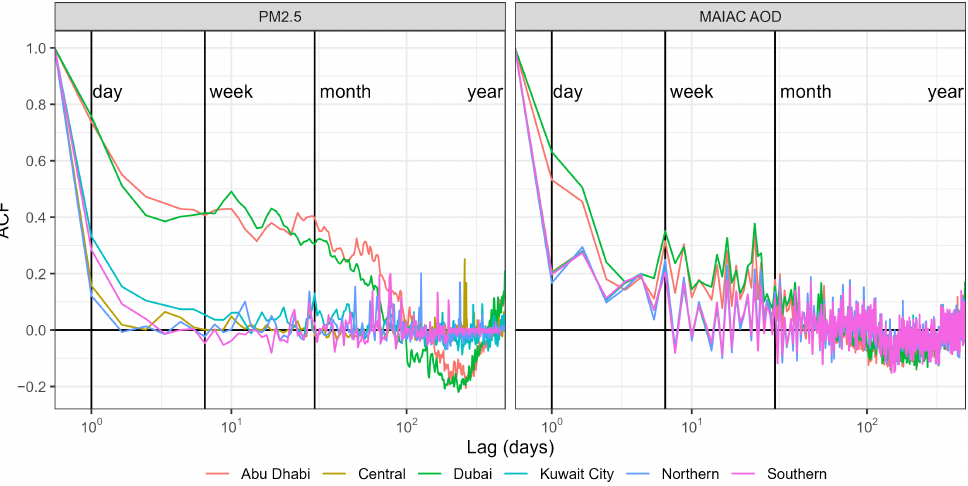
Figure 7. Autocorrelation functions for PM 2.5 ( left ) and median ACFs for MAIAC AOD ( right ) at different sites in Kuwait and the